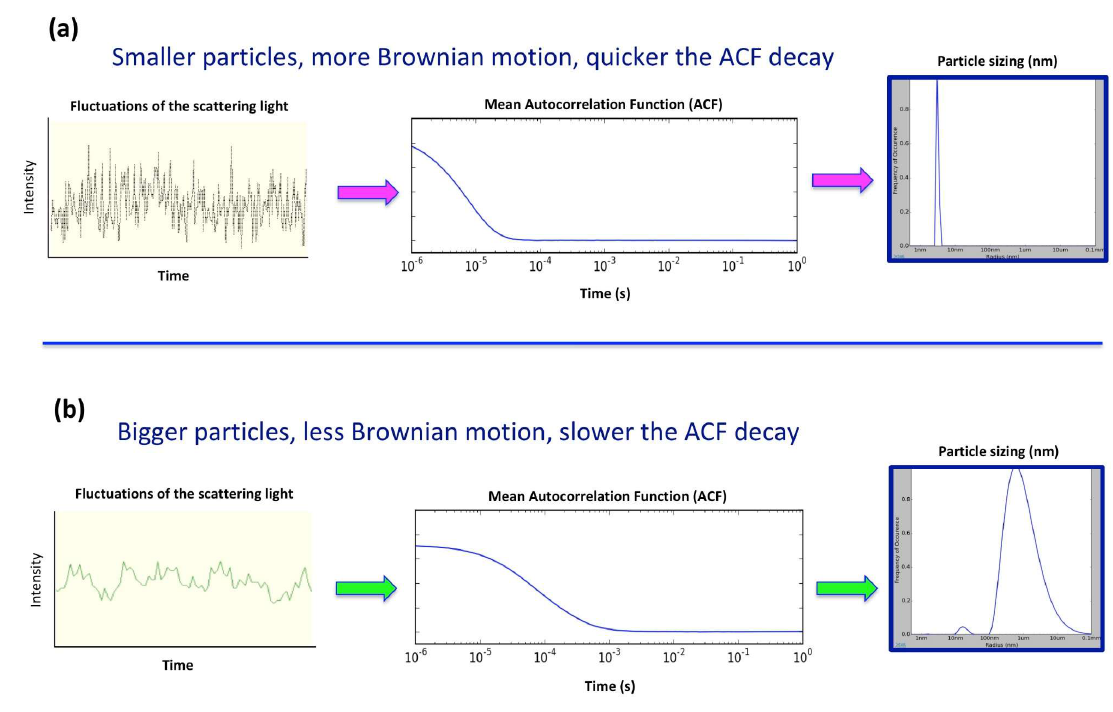
Figure 1. Graphic representation of the light scattering intensity fluctuation as a function of the particle size and its auto correlation function (ACF) decay for small ( a ) and large particles ( b ).